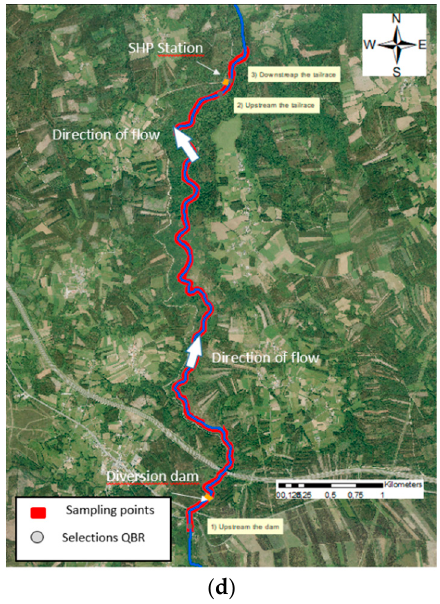
Figure 1. Location of the sample points. ( a ) Lerez river ( b ) Umia river ( c ) Ulla river ( d ) Mandeo river. Environmental characteristics assessed, parameters and index used, and location of the sampling points (grey circles). Riparian habitat sections, where the QBR (riparian forest quality index) was calculated (red).